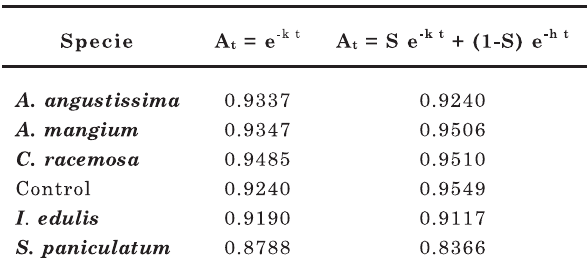
Table 2. Correlation coefficients for single (A = e -k t ) t and double (A = S e -k t + (1-S) e -h t ) exponential t equation that were used to calculate the decomposition rate constants, where A is the t proportion of material remaining at time t ; S is the initial proportion of labile material; (1-S) is the initial proportion of resistant material; k is the rate constant for the labile component; and h is the rate constant for the resistant